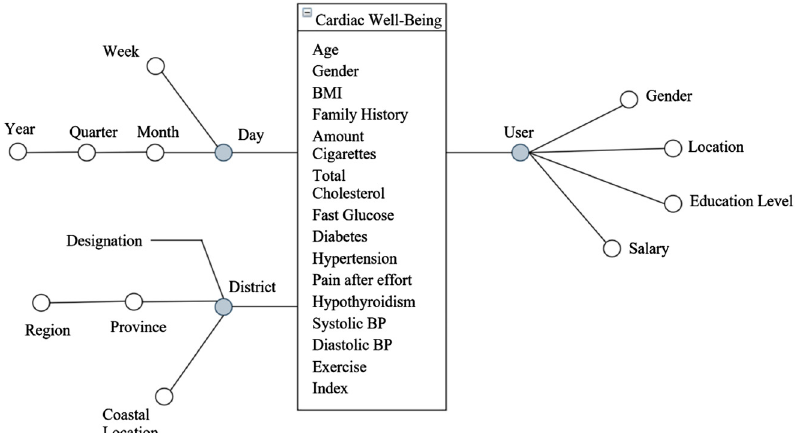
Figure 1: The multidimensional schema of the data